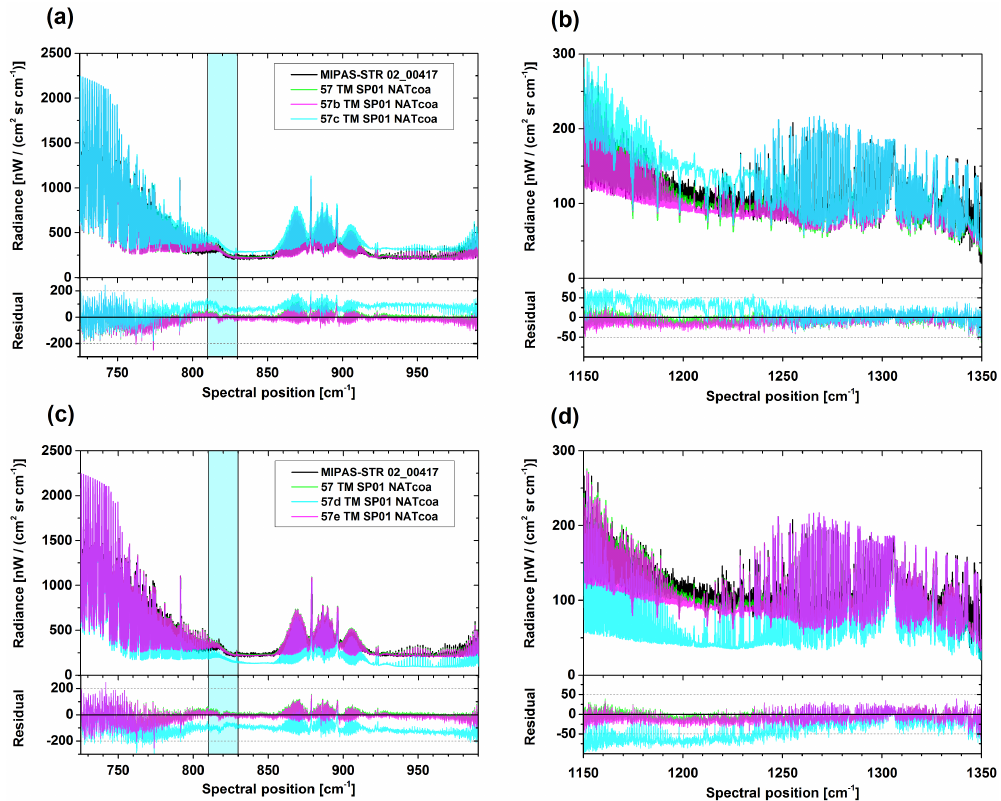
Figure 15. Influence of the tropospheric scenario on simulations of elongated spheroids with AR = 0.1 consisting of β -NAT. Black spectra in all panels: MIPAS-STR limb observation (13:47UTC, tangent altitude 18.4km). Green spectra in all panels (mostly hidden by magenta spectra): optimized scenario. (a, b) Sensitivity simulations assuming an opaque tropospheric cloud between 0 and 2km (magenta) and the absence of any tropospheric cloud (cyan). (c, d) Sensitivity simulations assuming an opaque tropospheric cloud from 0 to 10km (cyan) and a surface temperature reduced by 7K (magenta). Numbers in the legend refer to scenarios in Table 1. “NATcoa” corresponds to β -NAT, “TM” to T-matrix simulation, and “SP” to spheroid (numbers indicate